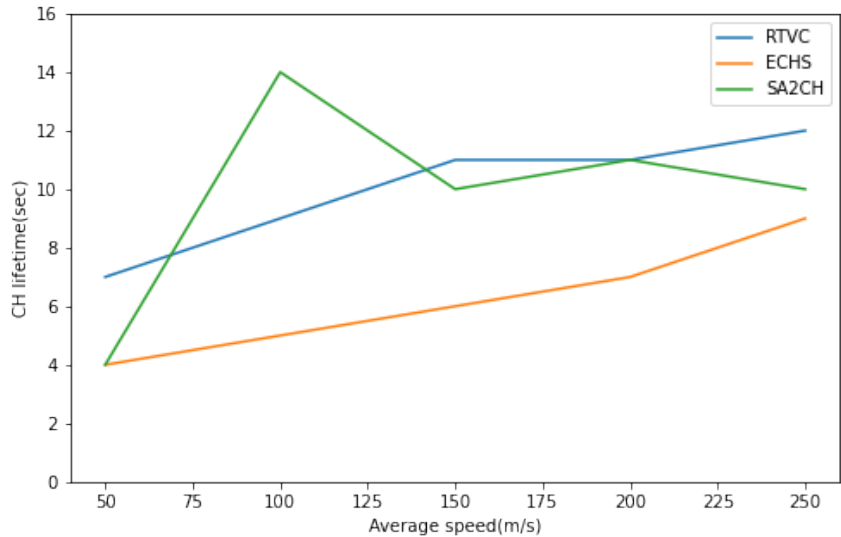
Figure 9. Comparative graph of CN between the existing and proposed technique.